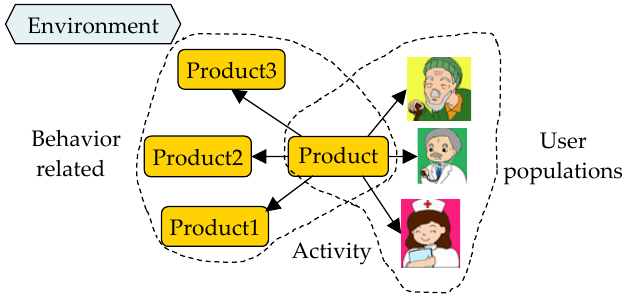
Figure 7. Scenario-related product-acquisition model based on the Figure 7. The scenario-related products acquisition model based on the object.